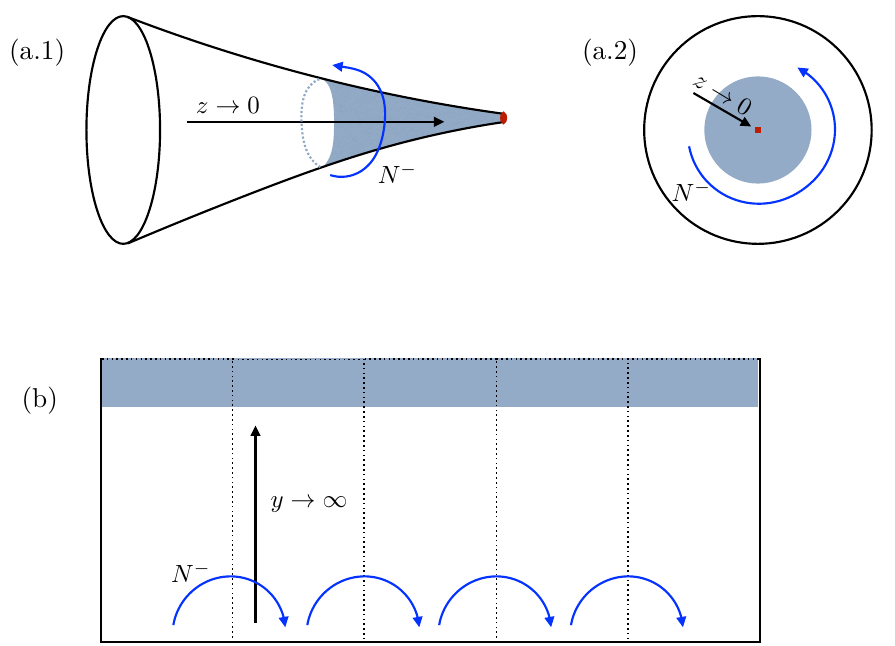
Figure 2: Schematic depiction of the asymptotic region in a complex one-dimensional moduli space. Figures (a.1) and (a.2) show the punctured disc parametrized by the complex coordinate z . The boundary of interest is the puncture at z = 0 . Figure (b) shows the universal cover of the punctured disc, the upper half plane parametrized by t = x + iy . The boundary of interest is now located at y = ∞ . We also indicate that there can be a log-monodromy matrix N − appearing in (2.12) when encircling the puncture or shifting in the upper-half